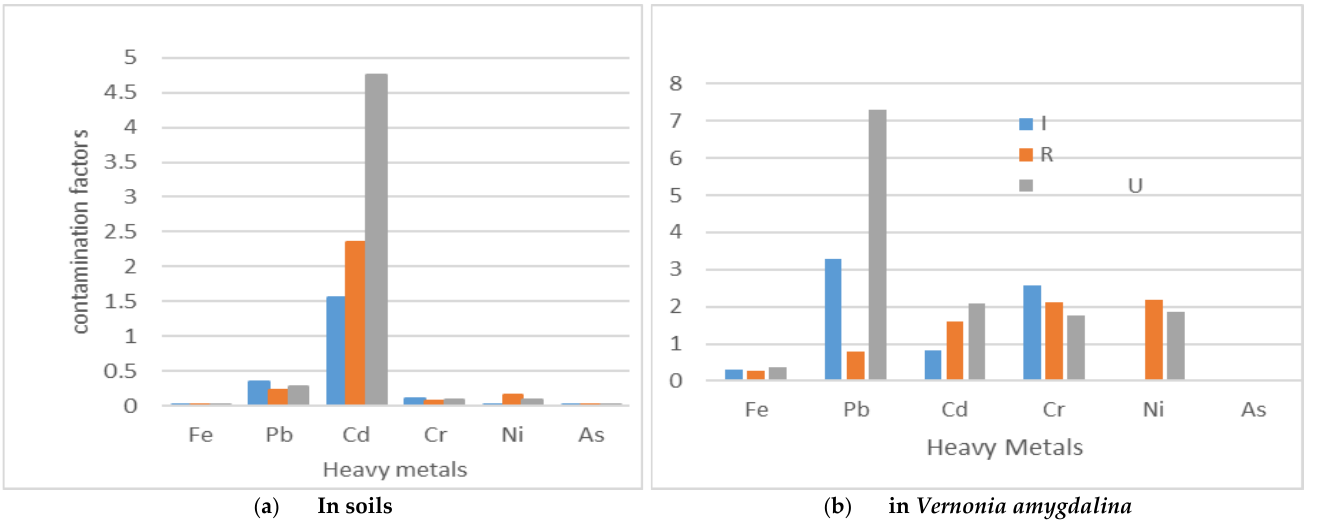
Figure 2. Trend of heavy metal (in mg·kg −1 ) contamination in soils (a) and Vernonia amygdalina (b)